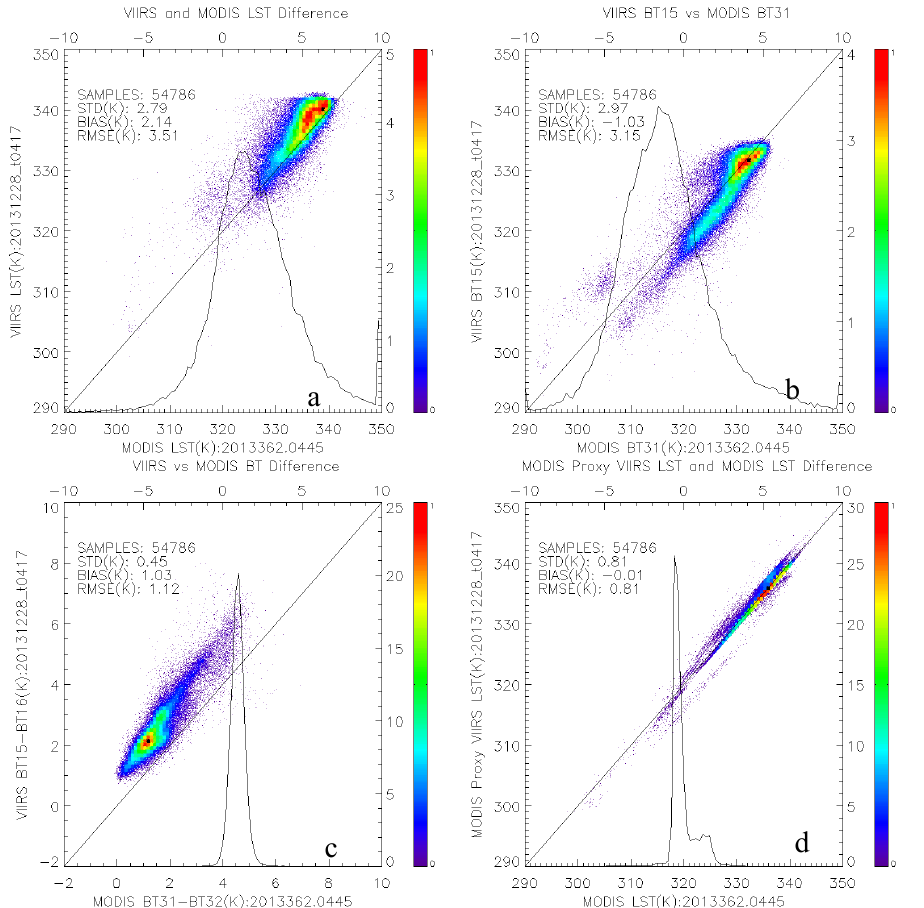
Figure 6. Cross-comparison results between VIIRS and AQUA of the case study on 28 December 2013. ( a ) Overall comparison results under cloud clear condition; ( b ) Brightness temperature comparison of VIIRS band 15 and MODIS Aqua band; ( c ) the BT difference comparison between VIIRS (BT15-BT16) and MODIS (BT31-BT32); ( d ) 31 based on a, VIIRS LST is calculated using MODIS data as input and then compare to MODIS